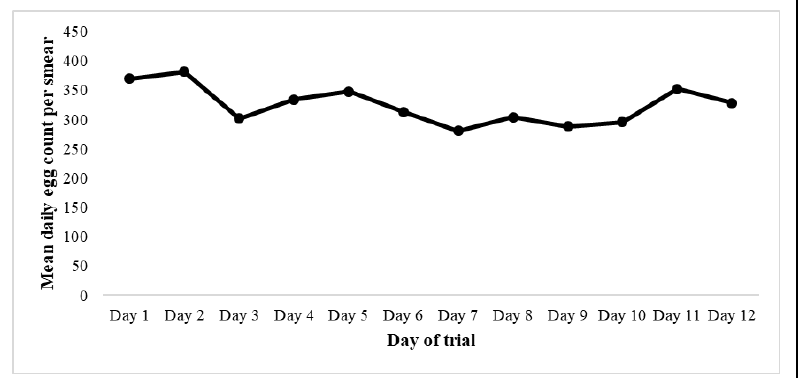
Figure 1: Mean daily egg count. Nb. before phase/treatment (day 1– 5); during phase/treatment (day 6–10); after phase/treatment (day